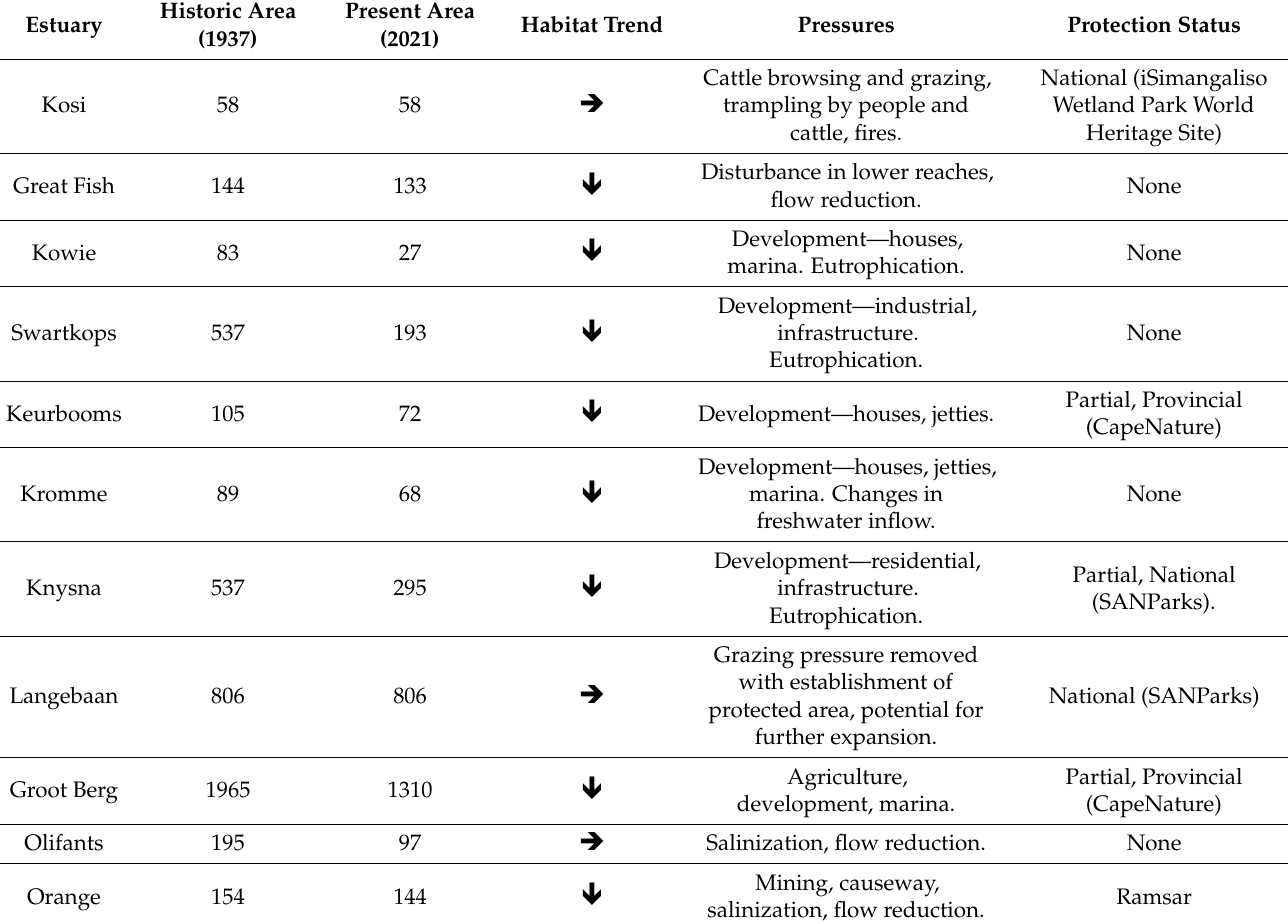
Table 1. Changes in the largest intertidal salt marsh areas (ha) in South Africa (east to west) and the associated pressures and protection status of each estuary. Habitat trends are indicated by arrows ( decreasing, increasing, and stable). Updated from [33] and [54].